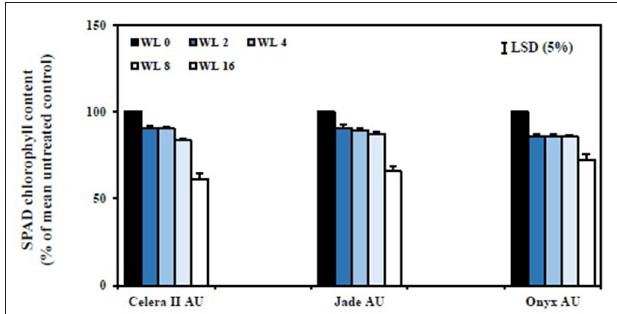
FIGURE 8 | Relative chlorophyll content (SPAD readings of the first trifoliate leaf) of different genotypes at the end of the recovery (39 DAS). The percentage of SPAD chlorophyll content for WL plants was estimated relative to their drained controls. WL0, drained control; WL2, waterlogging for 2 days, recovery for 22 days; WL4, waterlogging for 4 days, recovery for 20 days; WL8, waterlogging for 8 days, recovery for 16 days; WL16, waterlogging for 16 days, recovery for 8 days. Data are means ± SE of four replicate pots. Vertical bars are LSD at P = 0.05 for the